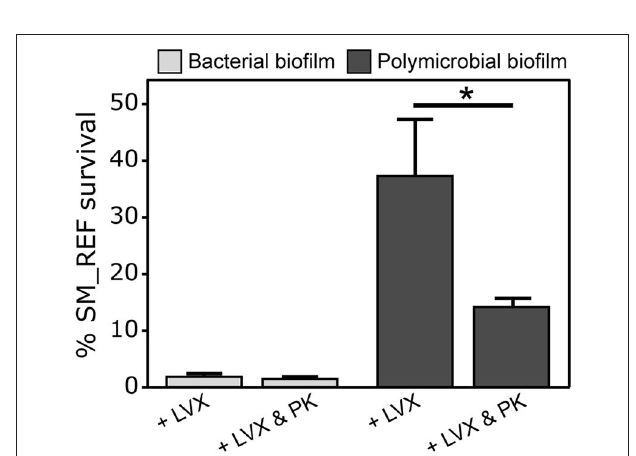
FIGURE 8 | Effects of A. fumigatus matrix on S. maltophilia biofilm susceptibility to levofloxacin. Bacterial and polymicrobial biofilms were treated with or without proteinase K (50 µ g/mL) for 2h before LVX treatment at 1 µ g/mL. Percentages of SM_REF survival was assessed using viable